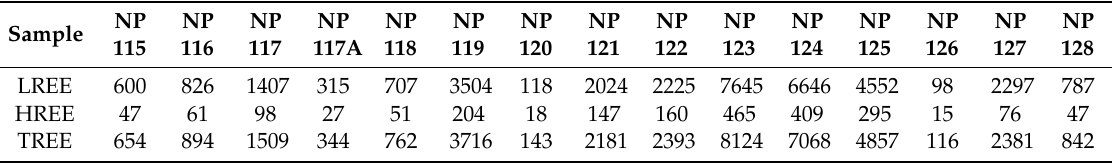
Figure 4. REE patterns of Nea Peramos heavy mineral (HM) sands. Red-colored line highlights the most REE-enriched sample #123. Normalization values of chondrite from [48]. Table 3. REE (Lanthanides, Sc, Y) contents of the Nea Peramos (NP) HM sands (in mg / kg). Light rare earth elements (LREE) group includes the elements from La to Sm, while heavy rare earth elements (HREE) group includes the elements from Eu to Lu; Y and Sc are included in total REE content, according to European Union (EU) definition